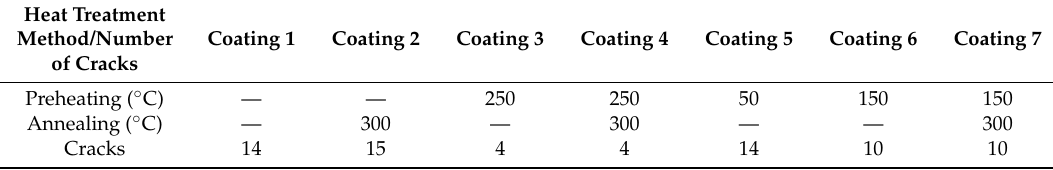
Table 3. Influence of heat treatment parameters on cracks.